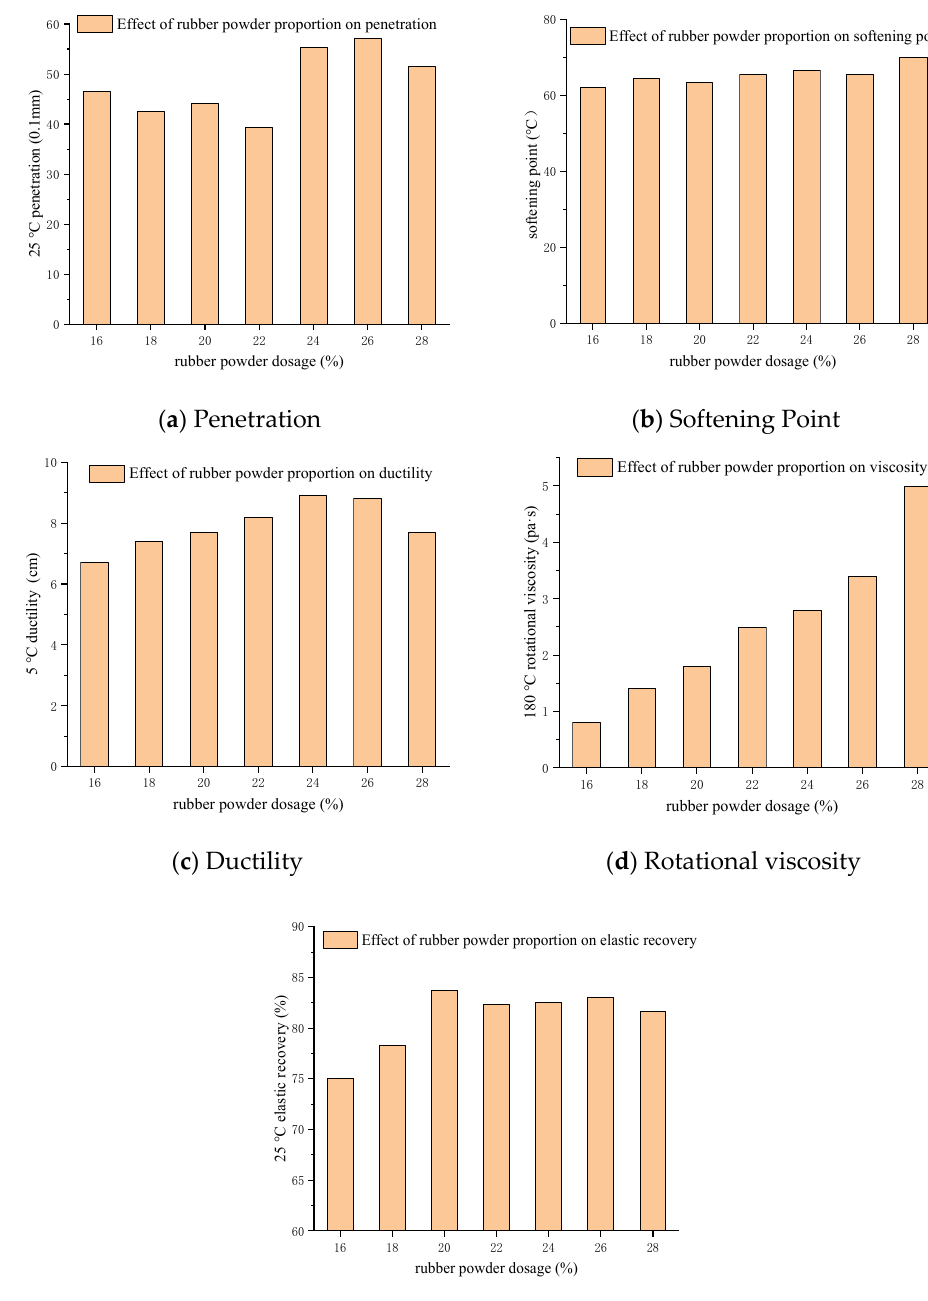
Figure 4. Effect of CR content on conventional tests result for 70# asphalt. Figure 4. E ff ect of CR content on conventional tests result for 70#